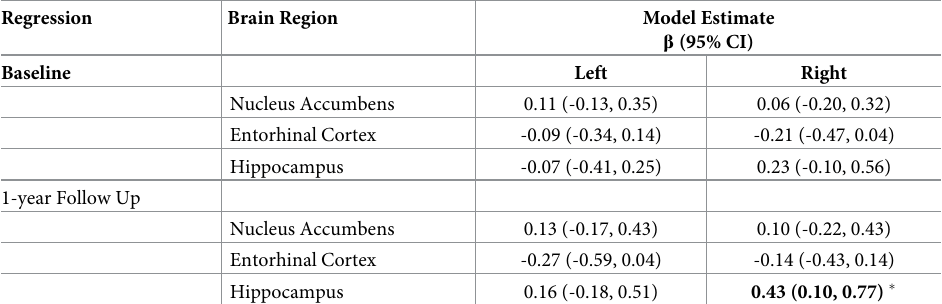
� Indicates p < 0.05. Models include control variables for estimated intracranial volume, age, sex, and pubertal status. Volumes are reported as sample standardized z-scores = Volume–Sample Mean Volume / Sample Standard